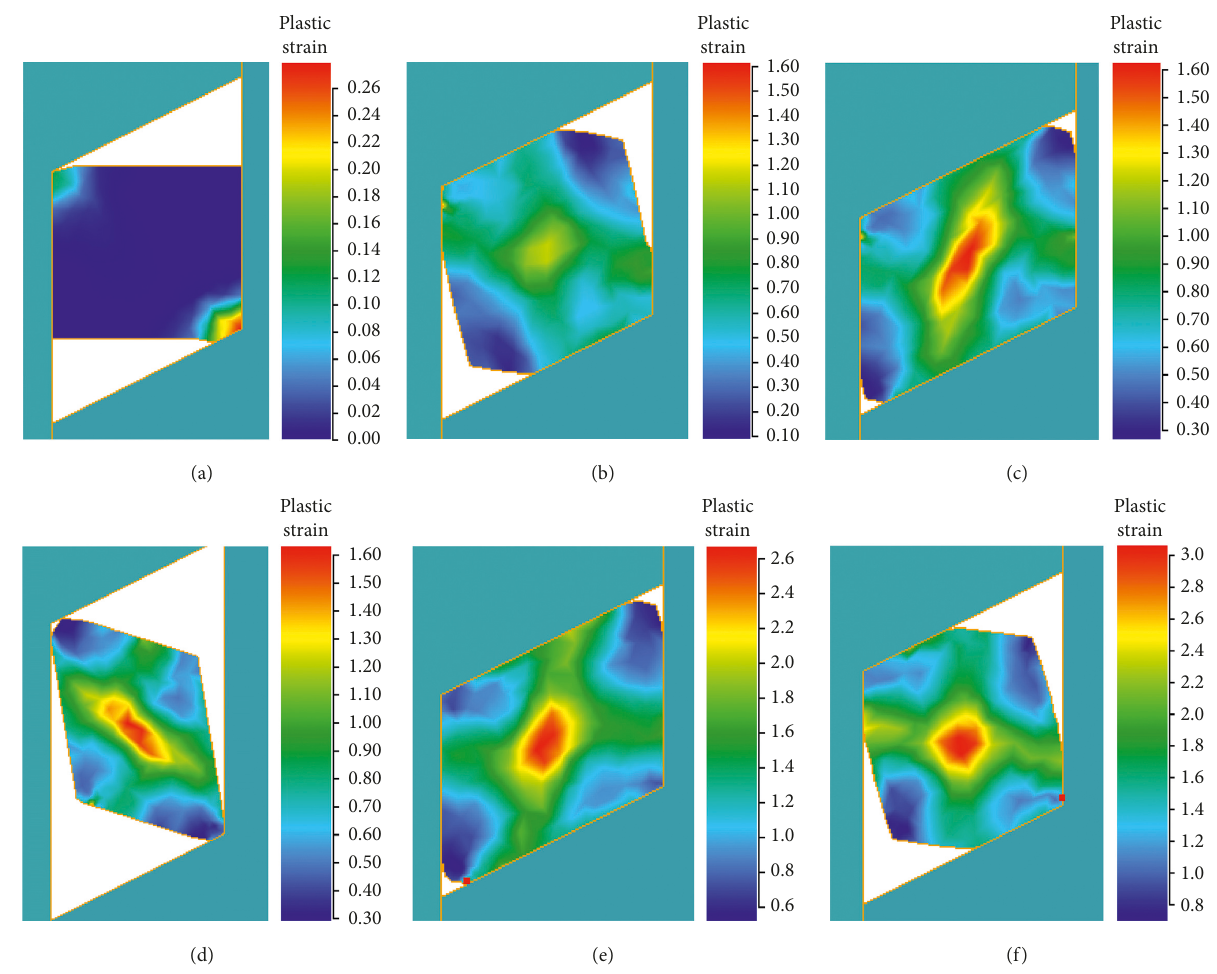
Figure 5: Distribution accumulated plastic strain values for the deformation operations using the RS-60 deformation route: 4 operations, material used is Cu-ETP copper, and friction 0.5 according to Levanov [34]. Workpiece dimensions: width 20 mm, height 18 mm, and length 80 mm. (a) Original position of the workpiece in the die. (b) Intermediate position of the workpiece at the 2nd stage of de- formation. (c) Position of the workpiece at the end of the 2nd stage of deformation. (d) Original position of the workpiece at the 3rd stage of deformation. (e) Position of the workpiece at the end of the 3rd stage of deformation. (f) Final position of the workpiece at the 4th stage of